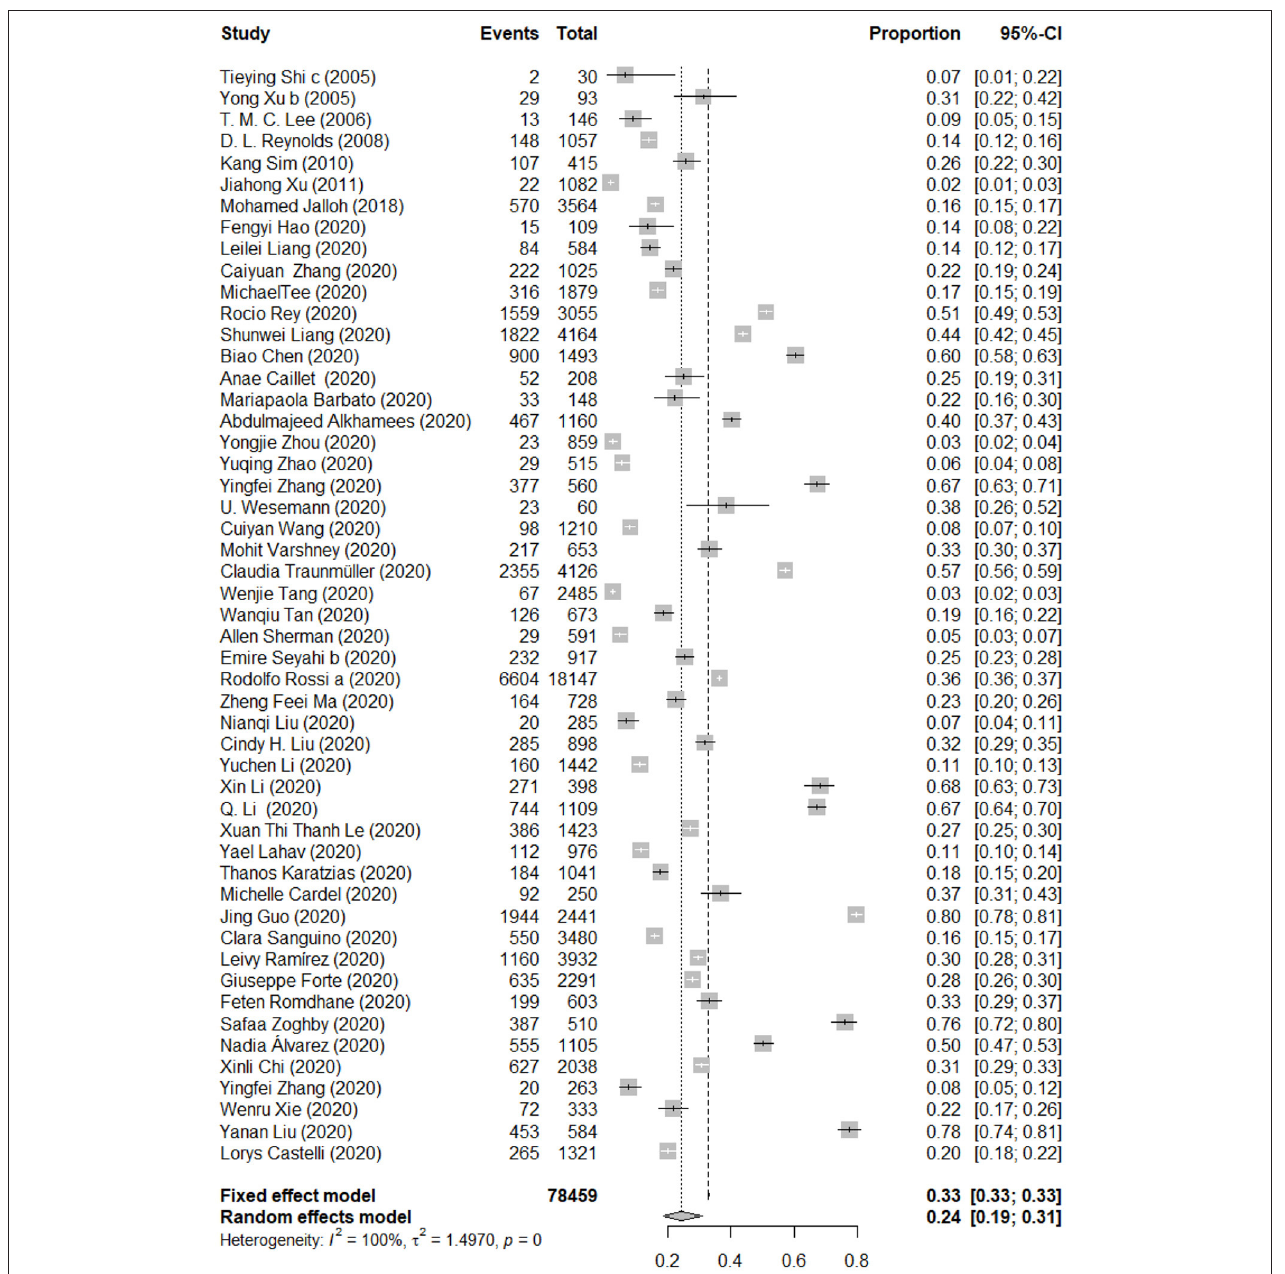
FIGURE 2 | Forest plots of pooled prevalence of post-traumatic stress symptoms among the general population.